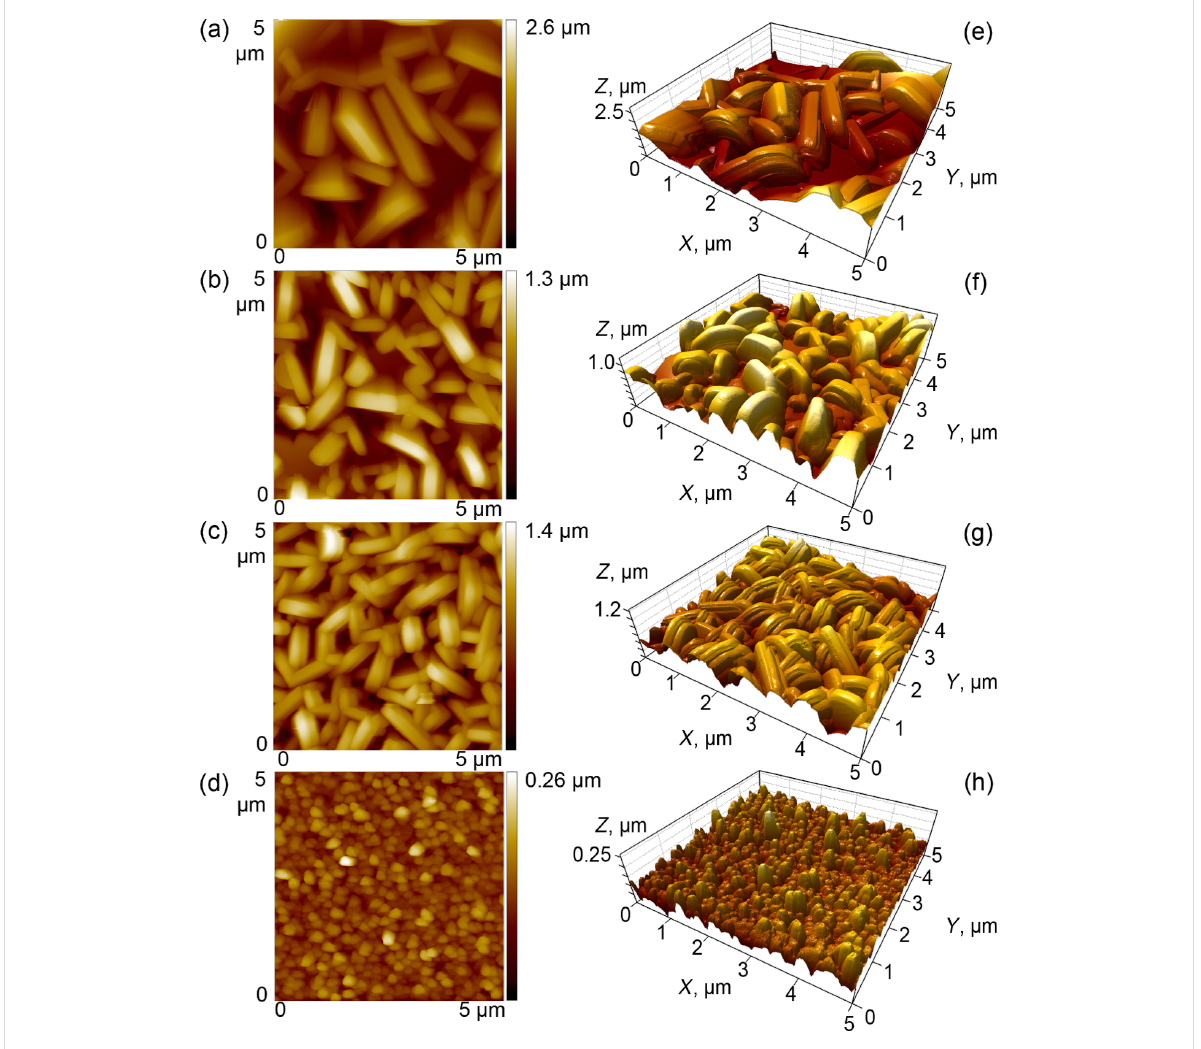
Figure 2: Atomic force microscopy (AFM) height images used for estimating the surface roughness parameters R a and r.m.s. (a–d) and three-dimen- sional projections (e–h) of wax surfaces created by alkanes of varying chain lengths: C 36 H 74 (a,e), C 40 H 82 (b,f), C 44 H 90 (c,g), and C 50 H 102 (d,h).